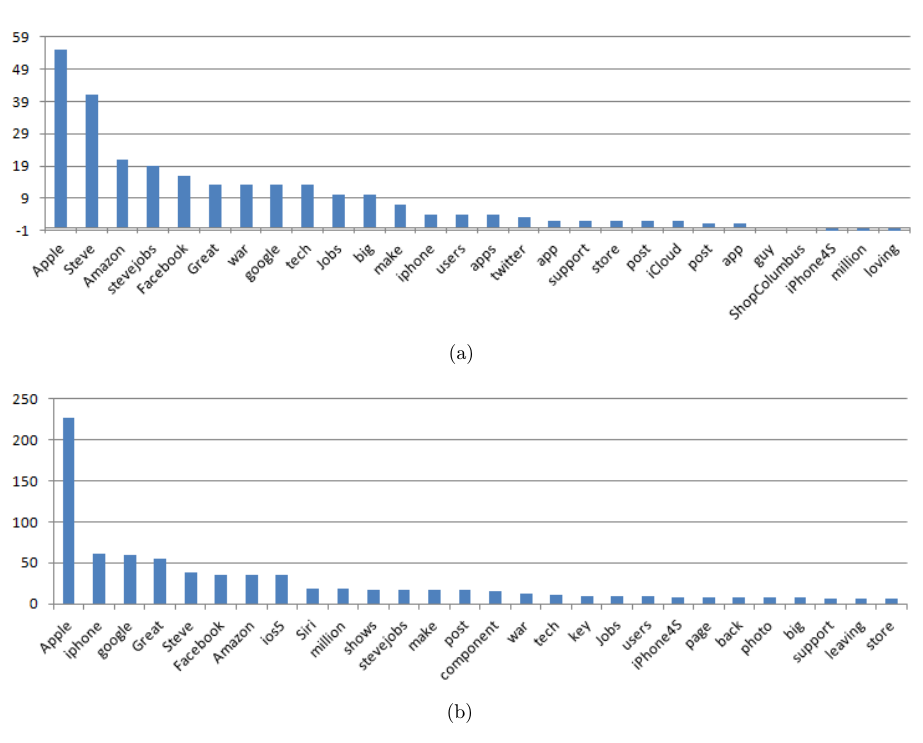
Fig. 9. Tracking concept drift and feature evolution in the Sanders